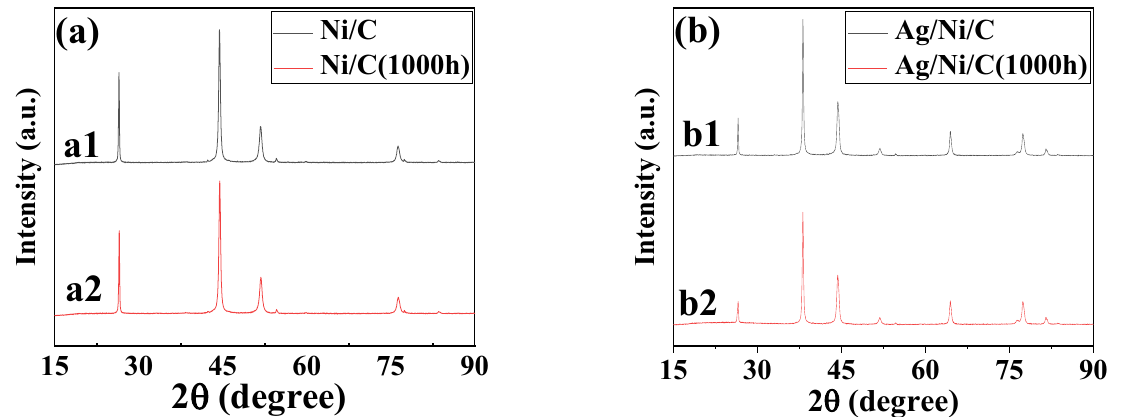
Figure 11. XRD patterns of the samples: ( a ) Ni/C powders pre- and post-HMT for 1000 h; ( b ) Ag/Ni/C powders pre- and post-HMT for 1000 h.